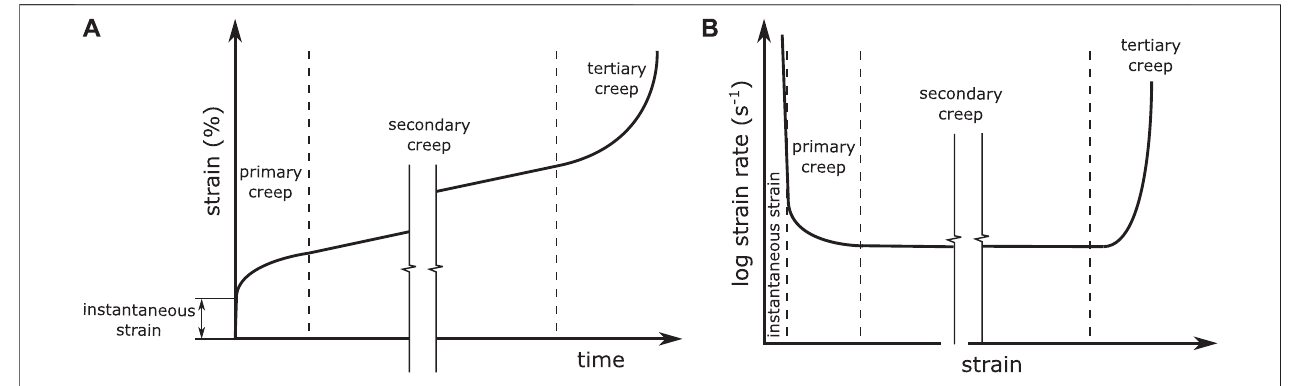
FIGURE 3 | Illustration of a creep curve with the three typically observed creep